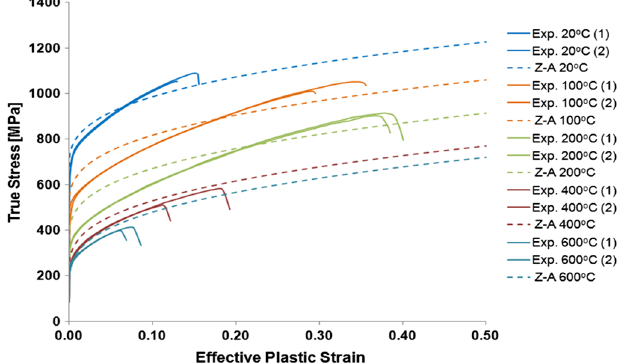
FIG. 10. Mechanical properties of INERMET ® 180 measured between room temperature up to 600 °C at the Politecnico di Torino. Two sets of experimental data (obtained from two samples in the same test conditions) are shown for each temper- ature at a fixed strain rate of 10 − 3 s − 1 . The Z-A model was then used to obtain a unique strength model for the material with a sufficient level of